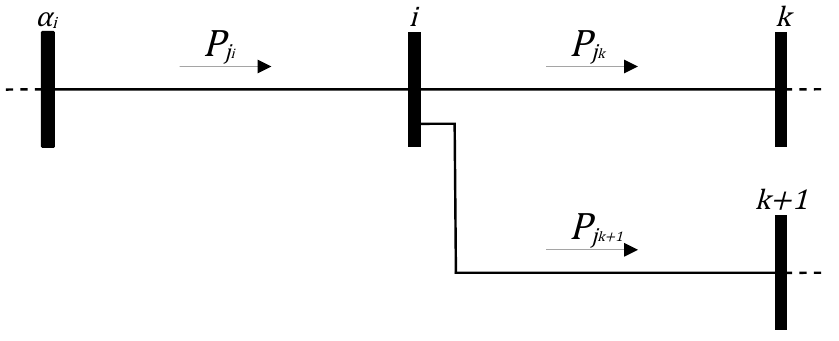
Figure 2. Illustration of part of the distribution